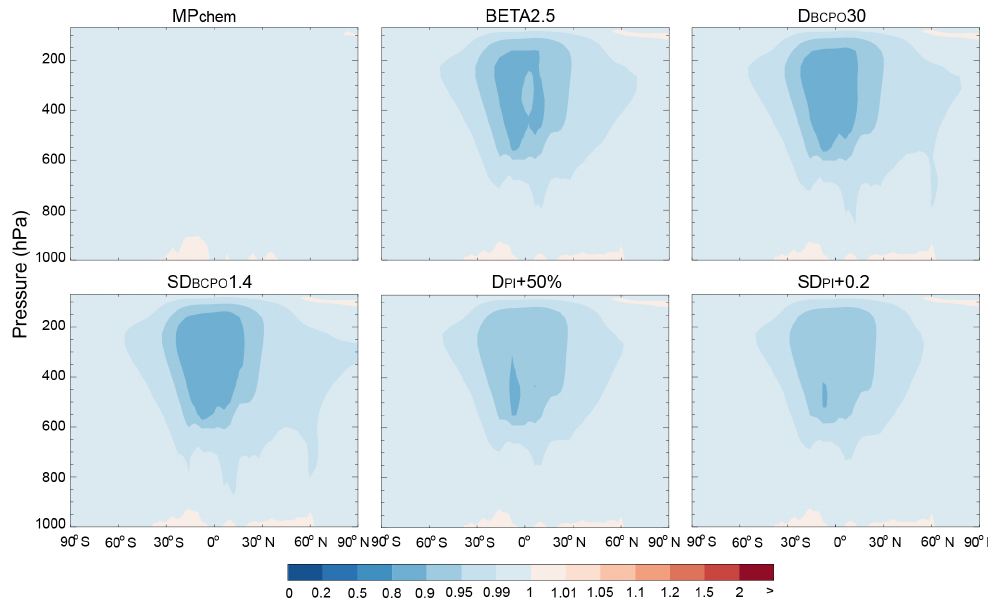
Figure 14. Same as Fig. 12 but for zonal mean BC